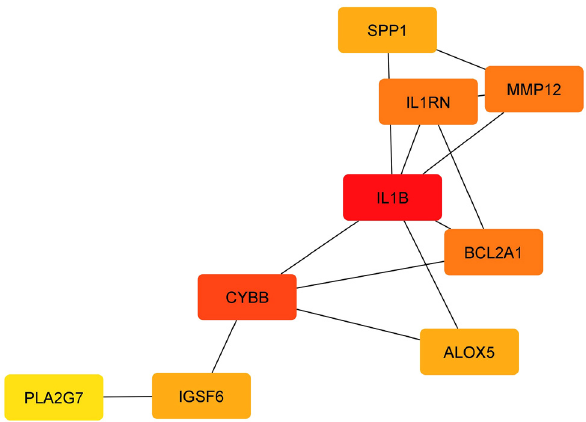
Figure 13: The most important common upregulated DEGs ( hub genes ) of the GSE5058, GSE11784, GSE11906, and GSE100927 datasets. Hub genes are ranked as follows: the most important genes are highlighted in red, the less important in orange, and even less important in